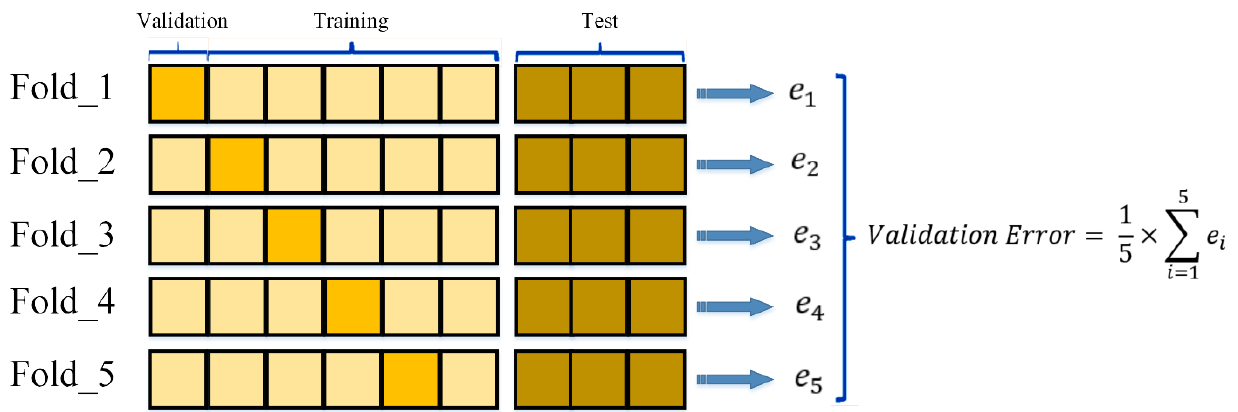
Figure 2. Five ‐ fold cross ‐ validation process presentation. Figure 2. Five-fold cross-validation process